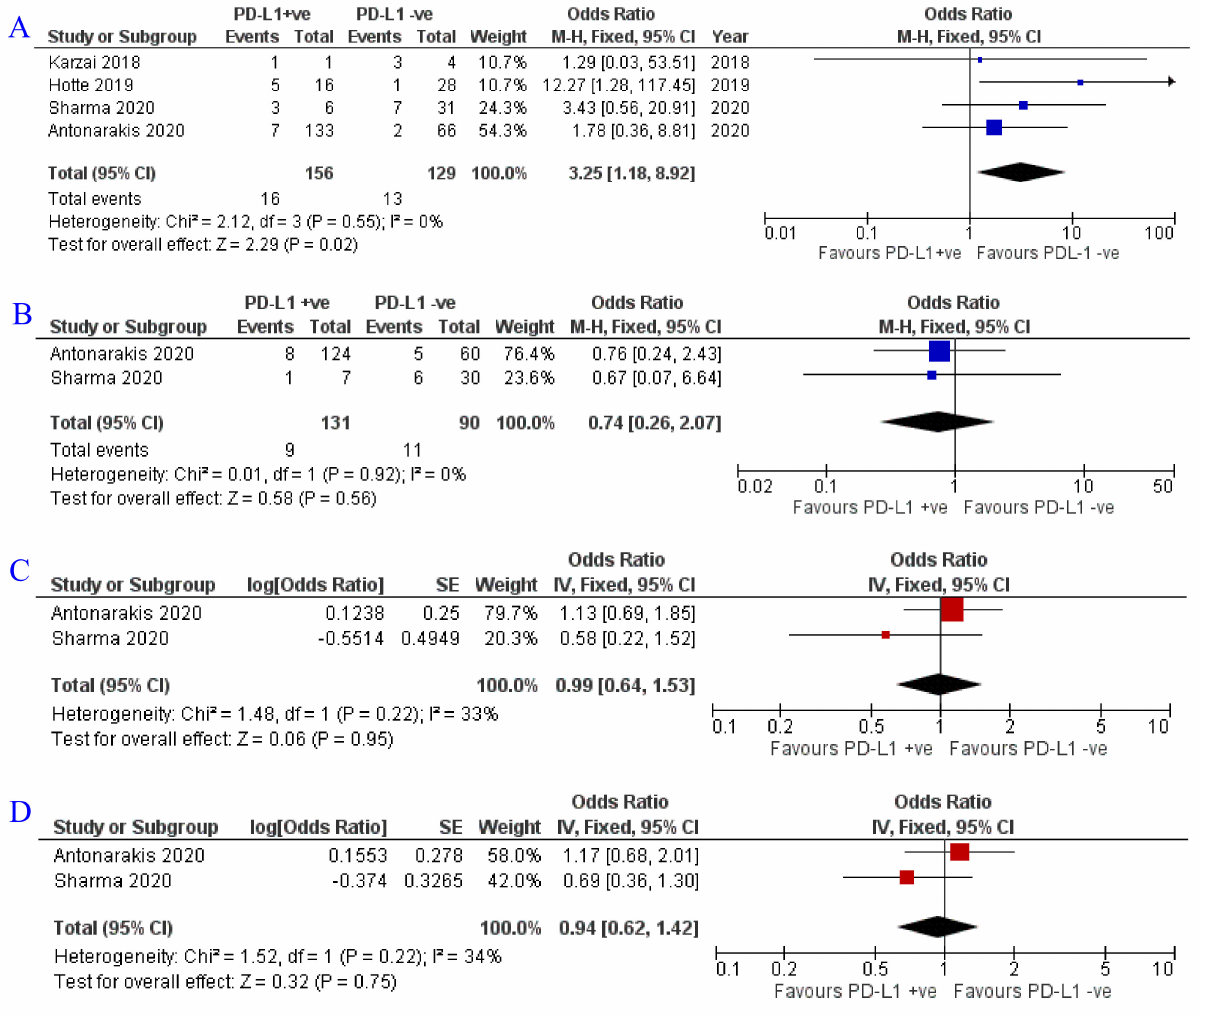
Figure 4. Forest plots for the impact of PD-L1 status on ( A ) ORR, ( B ) PSA RR, ( C ) PFS, and ( D ) OS. PD- L1, programmed death ligand 1; ORR, overall response rate, PSA RR, prostate-specific antigen response rate. Antonarakis et al., 2020 [21], Sharma et al., 2020 [19], Hotte et al., 2019 [26], Karzai et al., 2018